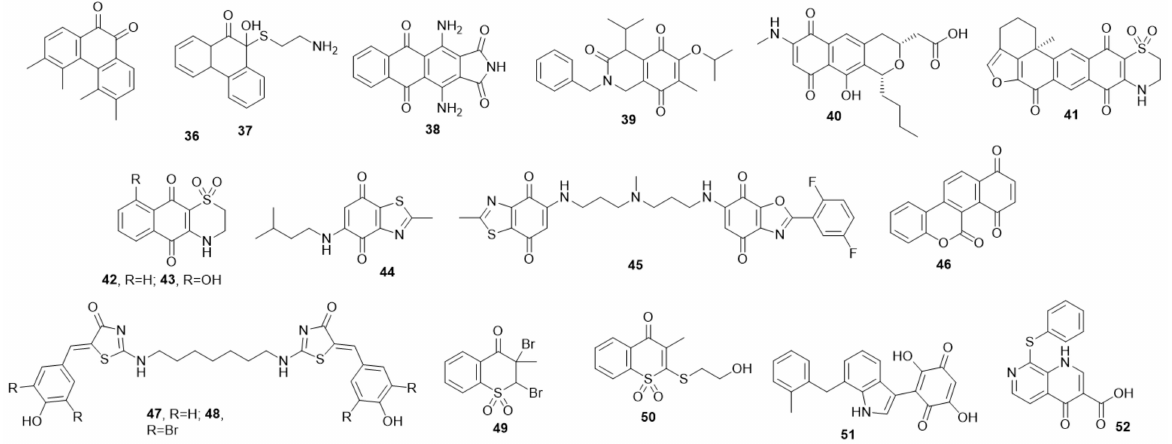
Figure 6. A library of small molecules structurally related to paraquinoid and non-para quinoid to be Cdc25 dual specificity phosphatase